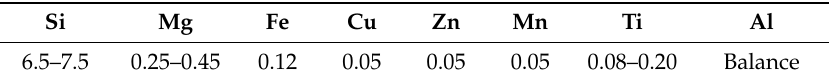
Table 1. Chemical composition of A356 Al alloy (wt